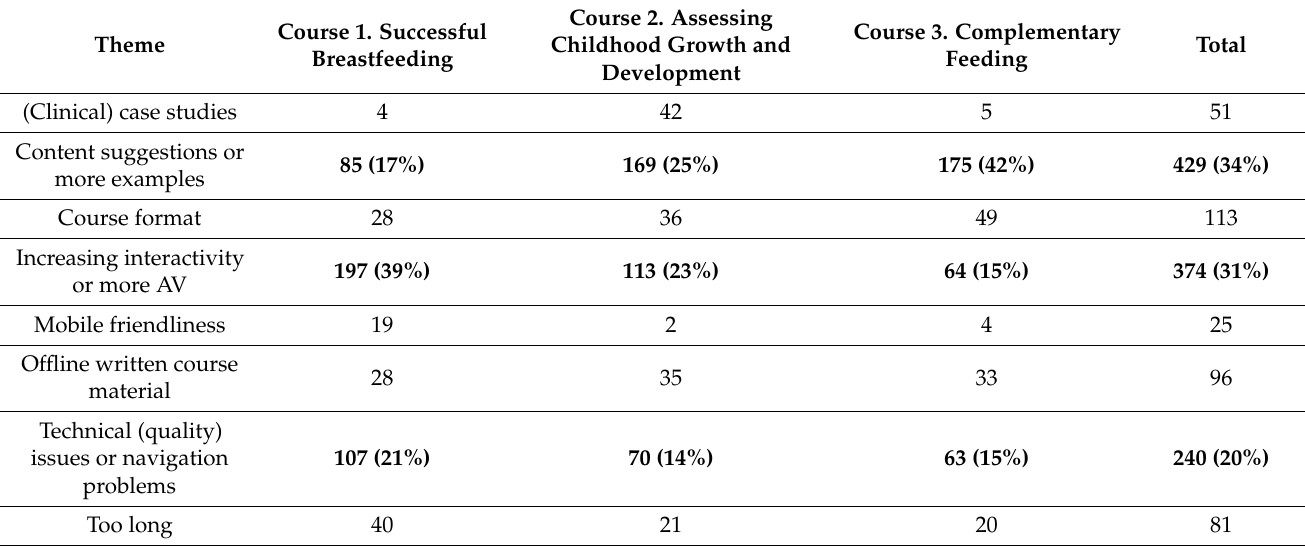
Table 4. Critical feedback and suggestions for improvement clustered in themes given in the open text fields of the English language evaluation questionnaires in each course and their prevalence in numbers ( n ) and % (defined by number of critical or suggestive user comments referring to a theme / total number of critical or suggestive user comments). Highest values are displayed in